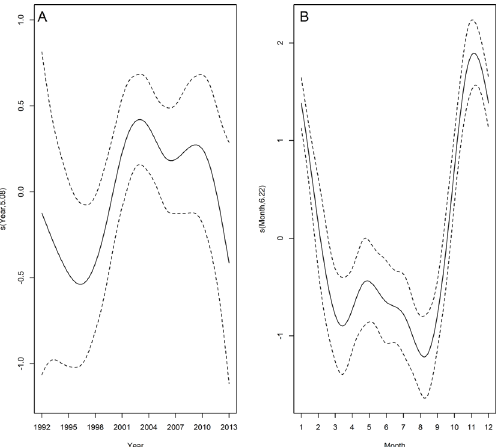
Fig 3. Temporal trends in franciscana strandings. Estimated smooth function (solid line) with 95% confidence interval (dashed lines) for the fitted GAM by year (A) and month (B) from 1992 to 2013. Y- axis = fitted function with estimated degrees of freedom in